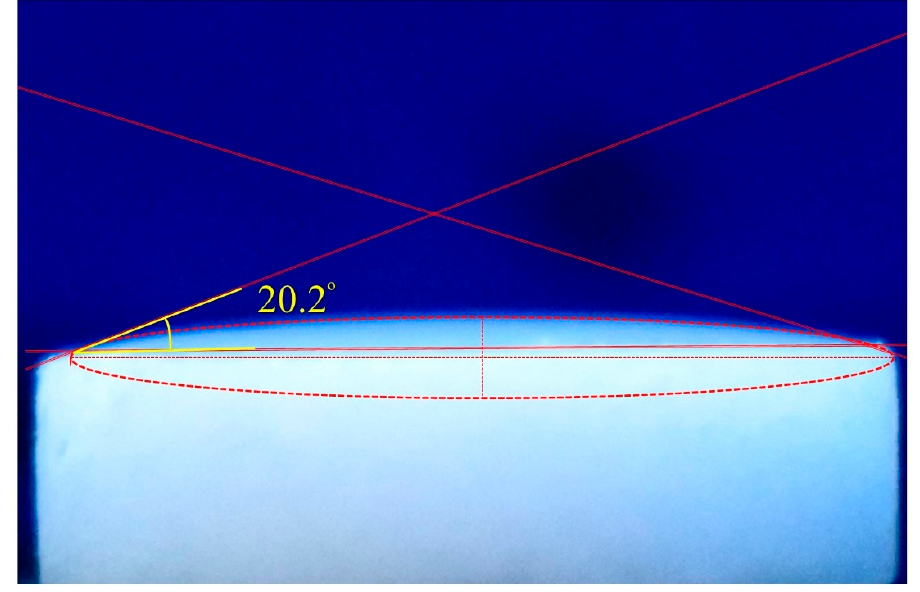
Figure 3. Contact angle of Docosane on the NPG surface at 70 °C.